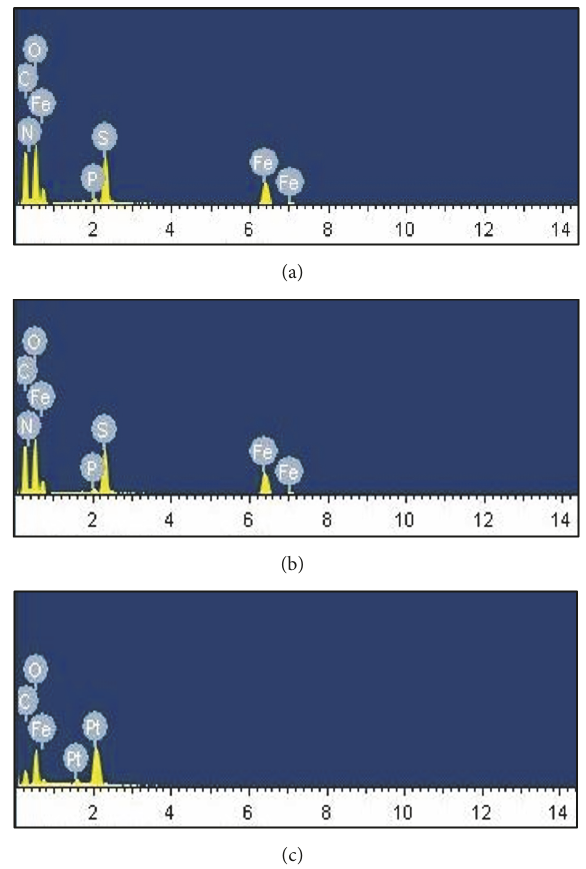
Figure 5: EDX spectra of carbon steel coupons: (a) control; (b) after addition of 90 mg/mL GTE; and (c) after addition of 90 mg/L of